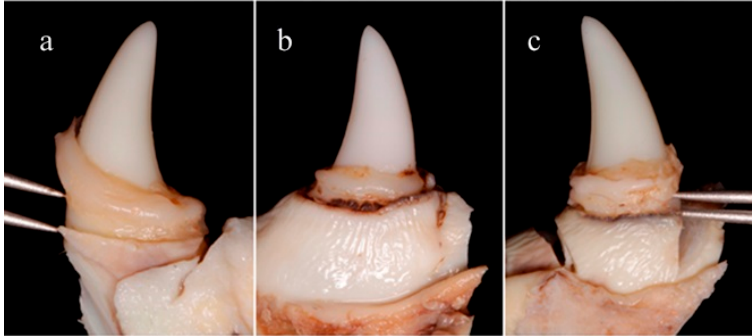
Figure 2. Images of specimens during measurements procedures in teeth with class V obturations with